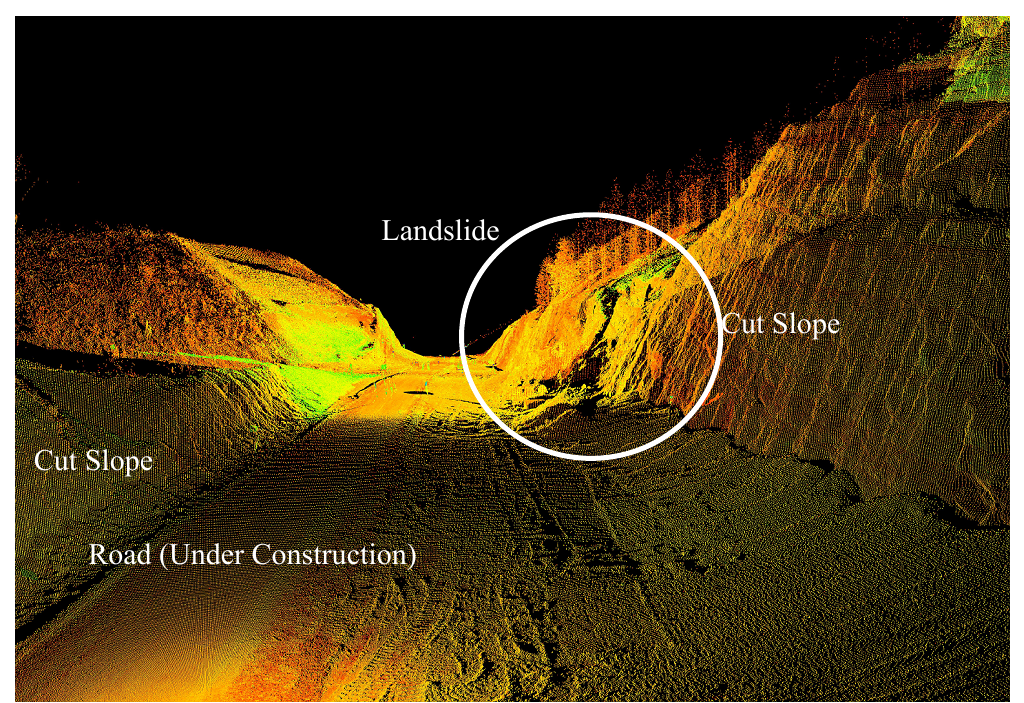
Figure 13. Point cloud of a rockfall on newly cut section for a highway (Courtesy of Oregon